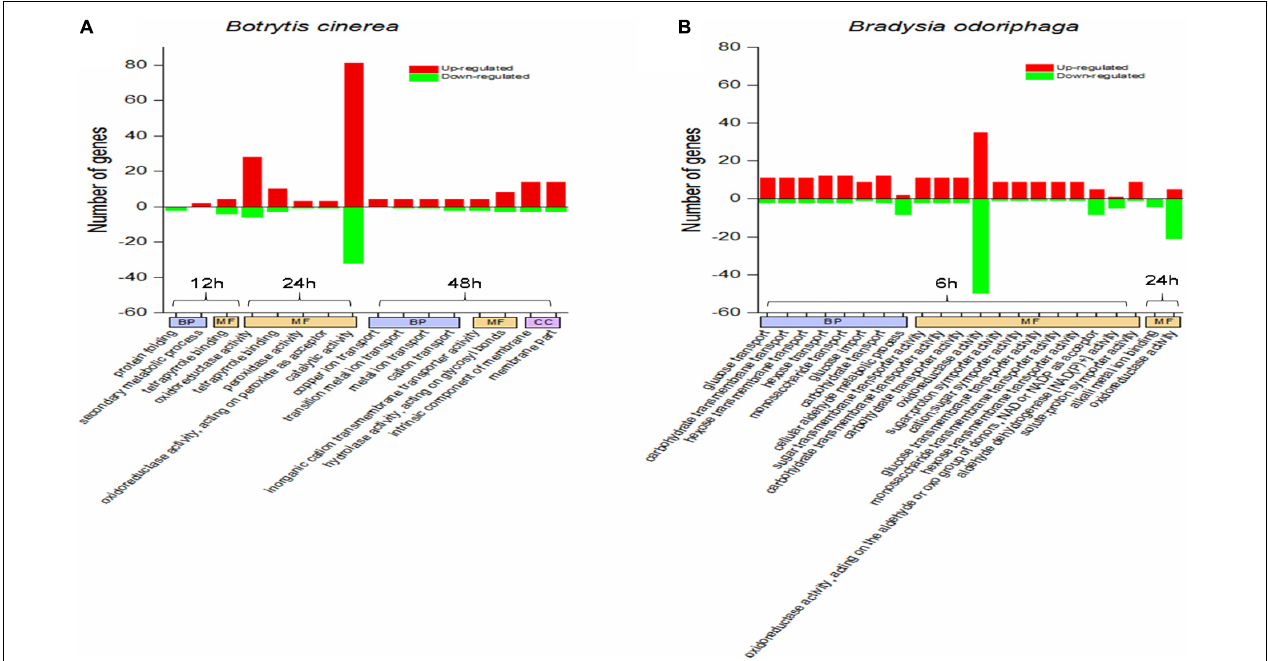
FIGURE 4 | GO term enrichment analysis for the DEGs in panels (A) Botrytis cinerea and (B) Bradysia odoriphaga. GO categories are functionally classified into biological process (BP), molecular function (MF), and cellular component (CC). The GO terms in the same category at the same time point are arranged from left to right in ascending order of P -values.